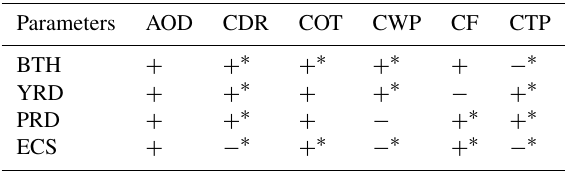
Table 1. The responses of cloud properties to the increasing AOD.